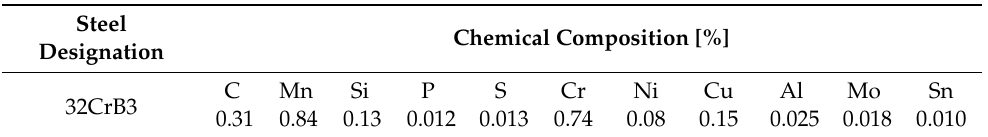
Table 2. Chemical composition of the 32CrB3 bolt steel according to the manufacturer’s quality certificate